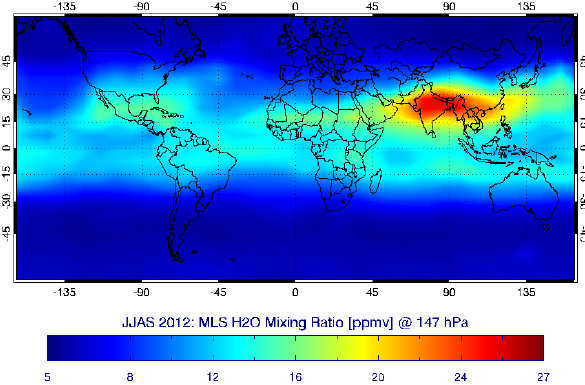
Fig. 1. Aura MLS water vapor mixing ratio (ppmv) at 147hPa av- eraged during June, July, August, and September 2012. The MLS data were binned into 5 ◦ latitude by 10 ◦ longitude cells similar to the method of Park et al.